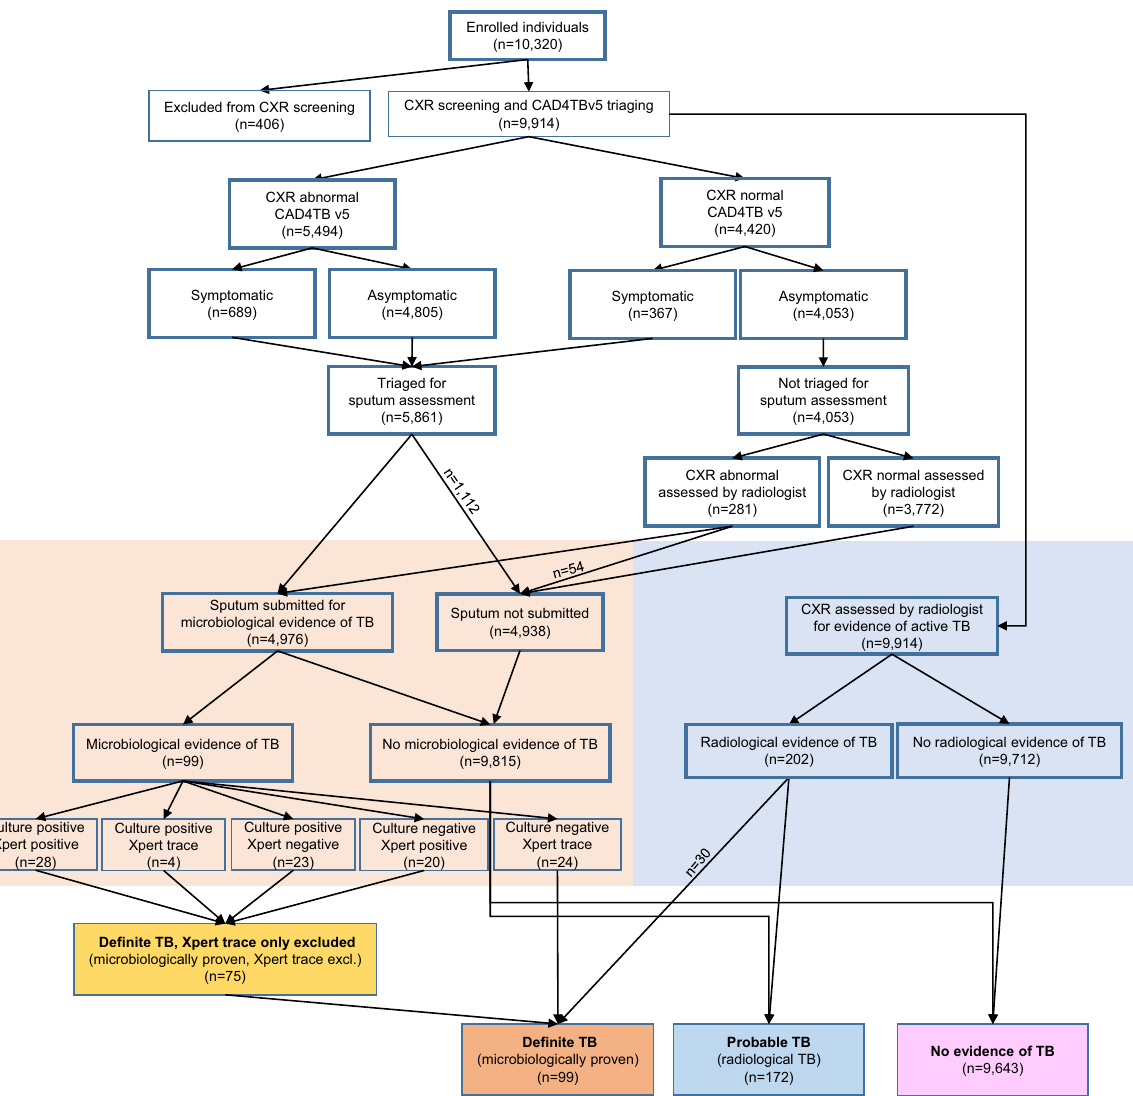
Fig. 1 TB screening in the fi rst year of Vukuzazi. A total of 10,320 participants were enrolled, of which 9914 underwent chest radiography. Participants were triaged for sputum collection if they had symptoms or if their CAD4TBv5 score was equal to or above the triaging threshold. For triaged participants who could spontaneously produce a sputum sample ( n = 4976), the sputum was tested with Xpert MTB/RIF Ultra and liquid culture. Independently, the radiologist indicated whether chest radiographs were normal or abnormal and if abnormal were diagnostic of active TB. If the radiologist indicated abnormal lung fi elds among participants who were not triaged in the camp, the sputum was collected during a home visit. Participants were grouped into de fi nite (microbiologically con fi rmed), probable (radiologically diagnosed), and no evidence of TB. A more stringent subgroup of de fi nite TB excluded participants whose only microbiological evidence of TB was an Xpert Ultra “ trace ”